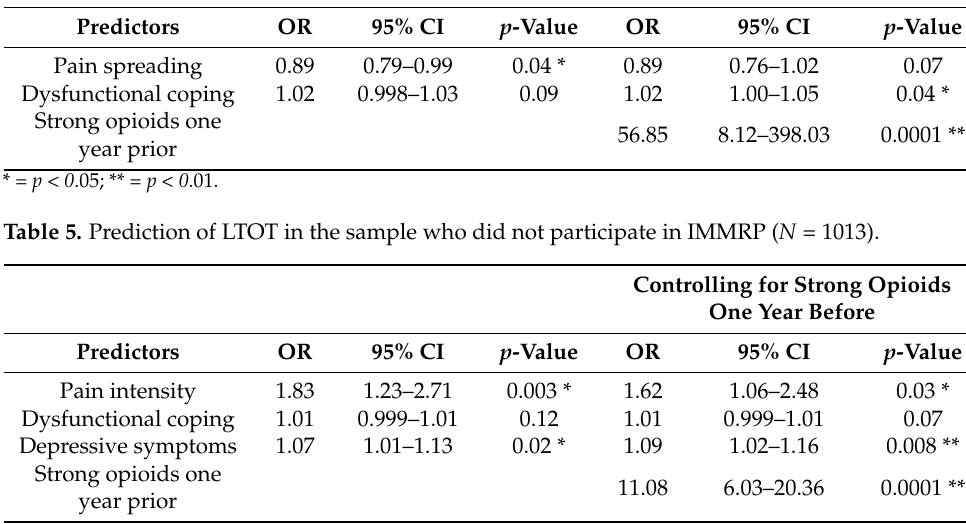
Controlling for Strong Opioids One Year Before